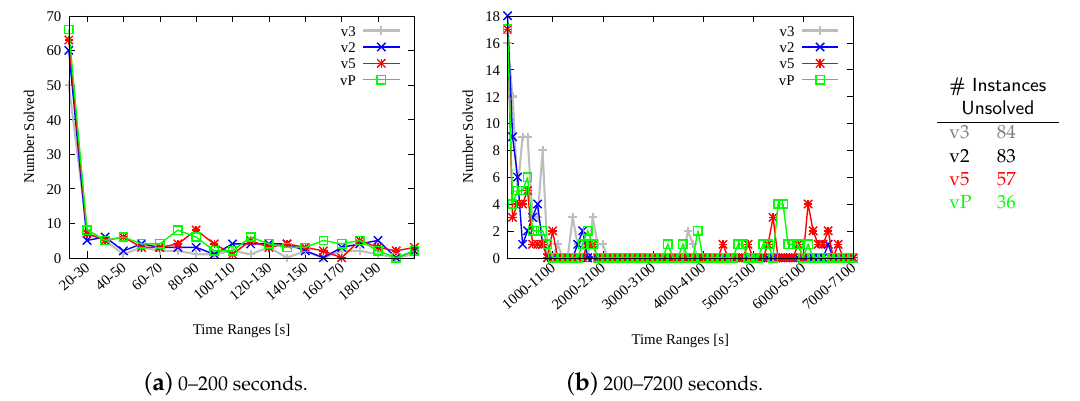
Figure 10. Scalability analysis for the MCS problem. ( a ) indicates the number of instances solved every 10 s, from 0 to 200 s. ( b ) reports the number of instances solved every 100 s, using a different scale on the y-axis. The table reports the number of unsolved instances (out of 250 and within 7200 s).